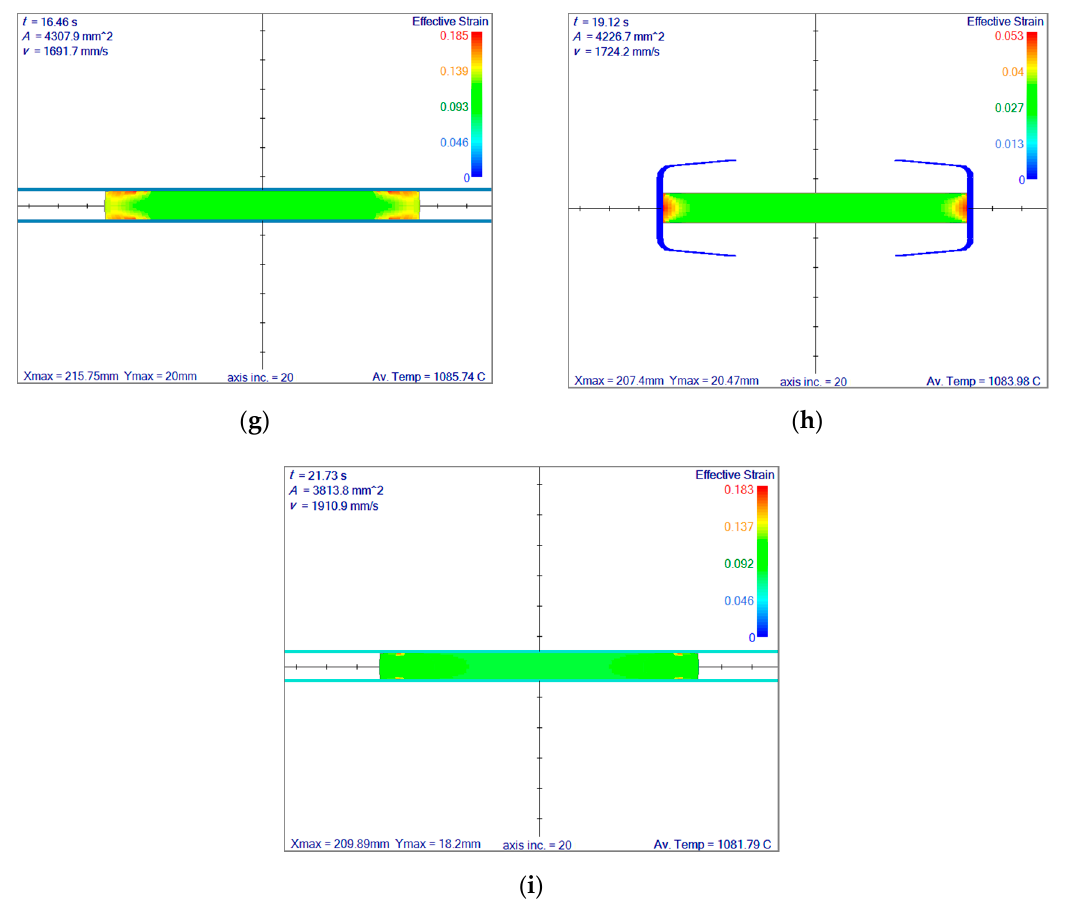
Figure 7. Flat rolling simulation results in terms of effective strain fields. ( a ) Initial size, ( b ) after first pass, ( c ) after second pass, ( d ) after third pass, ( e ) after fourth pass, ( f ) after fifth pass, ( g ) after sixth pass, ( h ) after seventh pass, ( i ) after eighth pass.